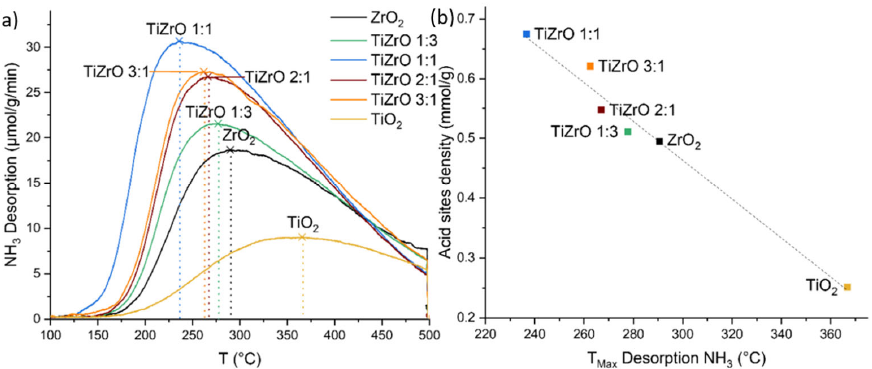
Figure 4. ( a ) TPD ‐ NH 3 profiles and ( b ) acid site density as a function of the maximum temperature of NH 3 desorption for the synthesized mixed oxides. of NH 3 desorption for the synthesized mixed